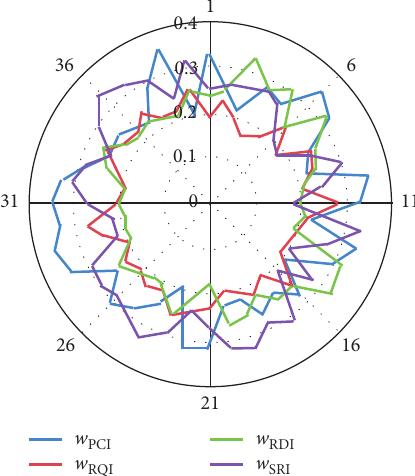
Figure 6: Weight characterization of pavement condition evaluation index.